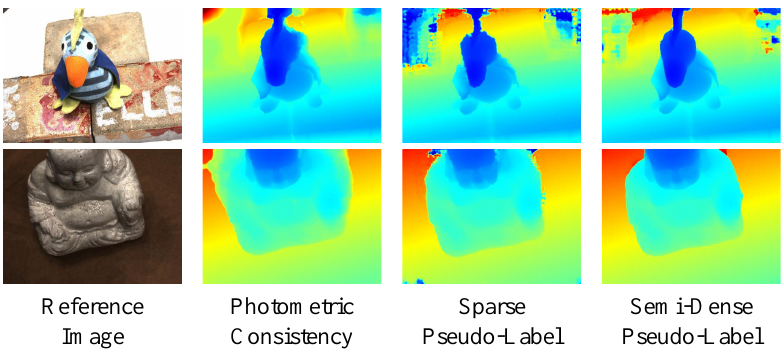
Figure 10. Quantitative results of depth estimation on the DTU dataset.